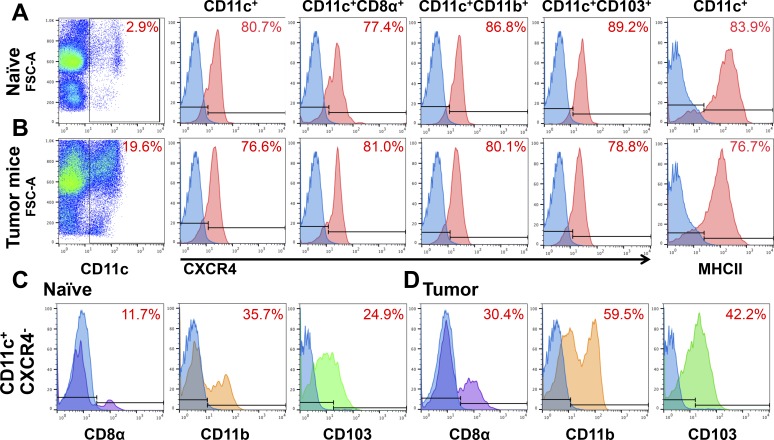
cDCs express CXCR4. Representative flow cytometry plots of CD11c+ cDCs from three spleens including cDC percentage of total splenocytes, expression of chemokine receptor CXCR4 in total cDCs and cDC subpopulations (CD8α+, CD11b+, and CD103+), and the cDC maturation marker MHC-II, respectively. CXCR4 was present in all CD8α+, CD103+, and CD11b+ cDC subsets, with similar expression in spleens from naïve BALB/c wild-type (A) and tumor mice (B). Analysis of CXCR4– splenic CD11c+ cDCs from wild-type (C) and tumor mice (D).